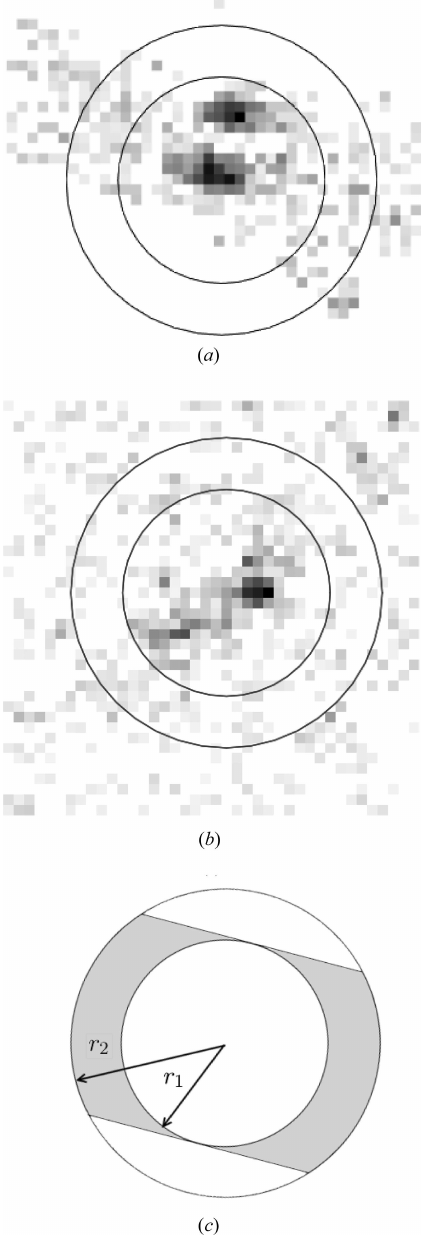
Figure 13 Diffracted intensity in a region around a reciprocal-lattice point in the three-dimensional merge and the integration cylinders, ( a ) on the equatorial and ( b ) on the first layer planes. ( c ) The region (shaded) where the background is